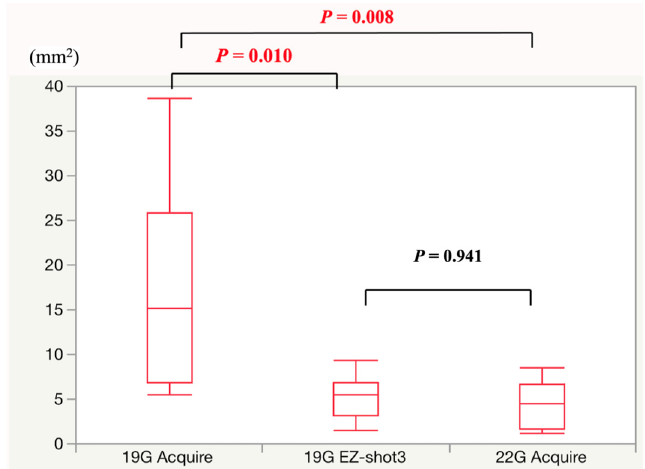
Figure 3. Area of the collected specimen measured by a Keyence digital microscope.